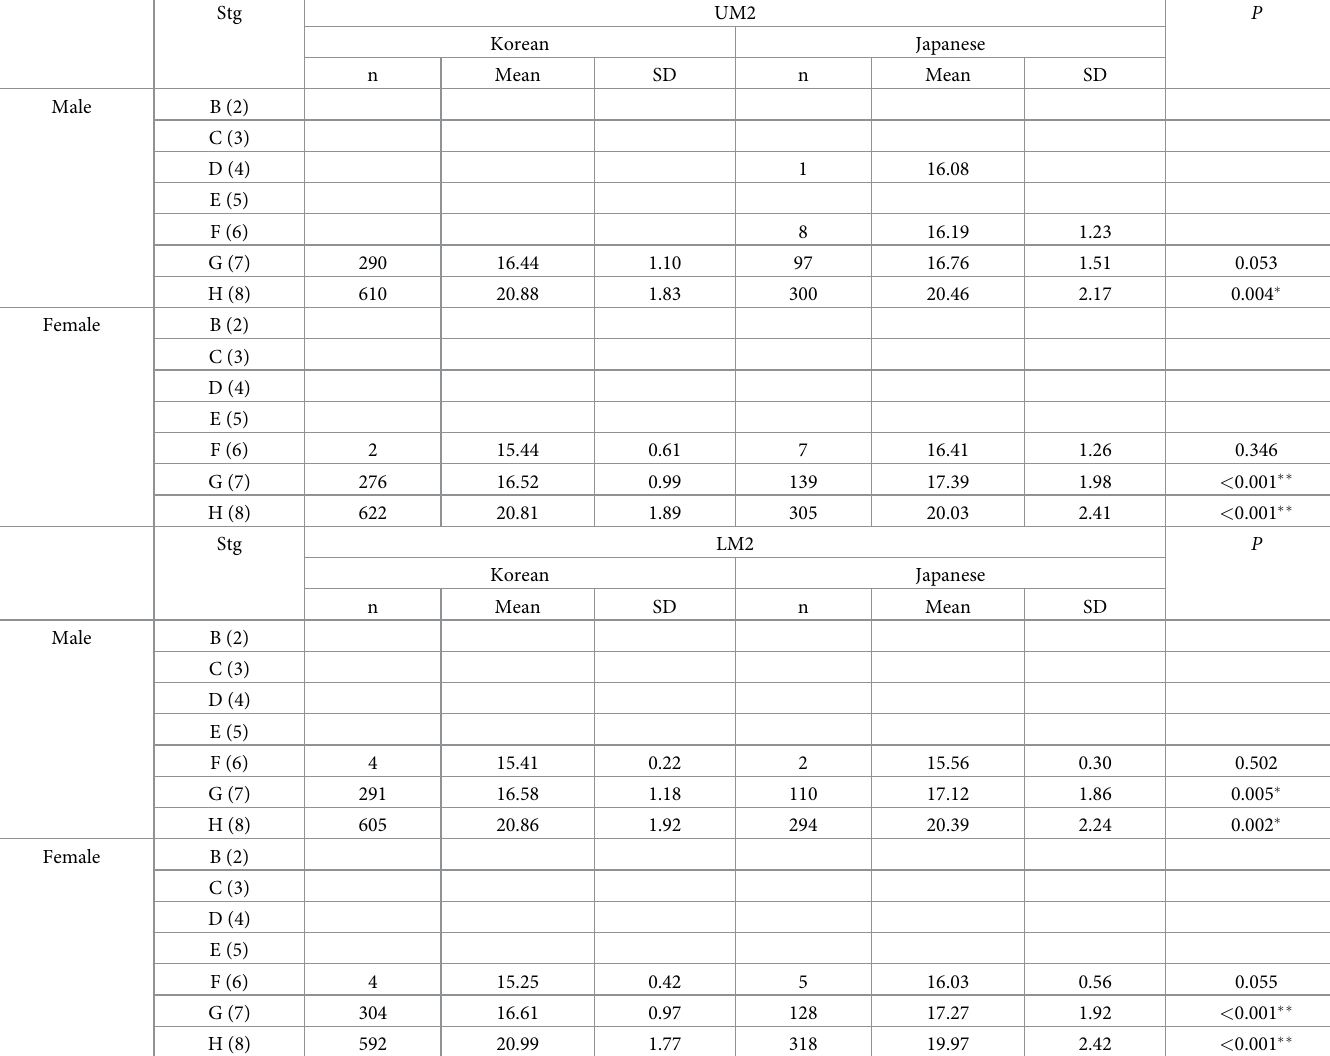
Table 2. Comparison of chronological age according to each stage of M2 between the Korean and Japanese populations. Stg